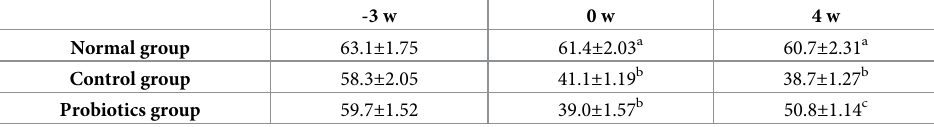
Table 3. The effect of probiotics treatment on total short-chain fatty acid concentration in faeces ( μ mol/g) in ade- nine-induced CKD